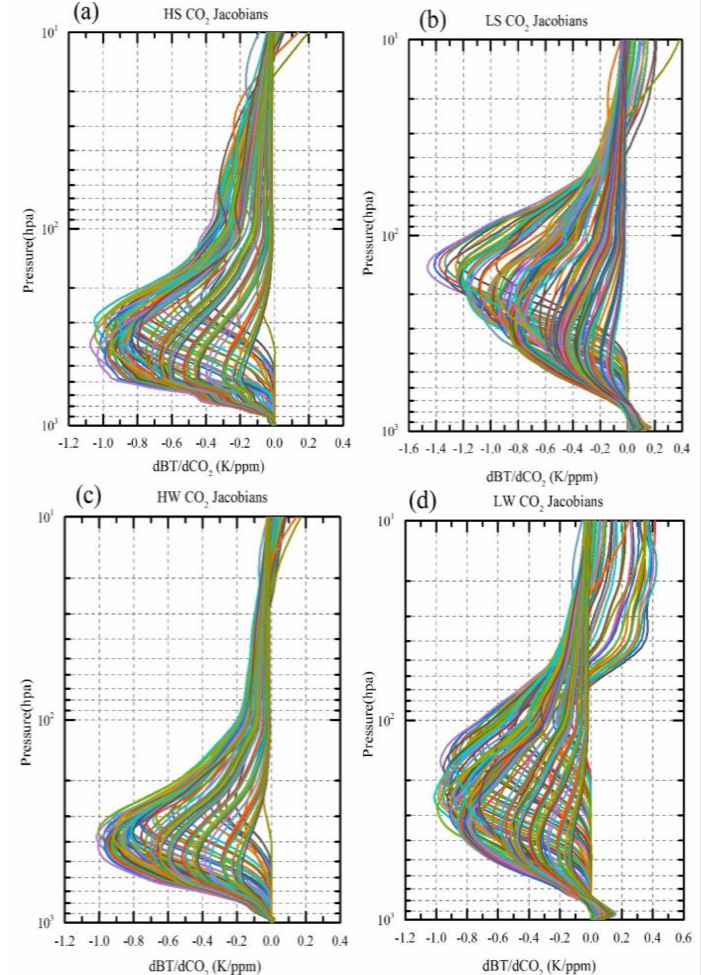
Figure 3. CO 2 Jacobians (K/ppmv) of the spectral bands from 700 to 755cm − 1 with a spectral resolution of 0.625 cm − 1 . ( a ) CO 2 Jacobians for high latitude in spring and summer (HS) (90–60 ◦ S and 60–90 ◦ N), ( b ) CO 2 Jacobians in low latitude in spring and summer (LS) (60 ◦ S to 60 ◦ N), ( c ) CO 2 Jacobians in high latitude in autumn and winter (HW) (90–60 ◦ S and 60–90 ◦ N), and ( d ) CO 2 Jacobians in low latitude in autumn and winter (LW) (60 ◦ S to 60 ◦ N).